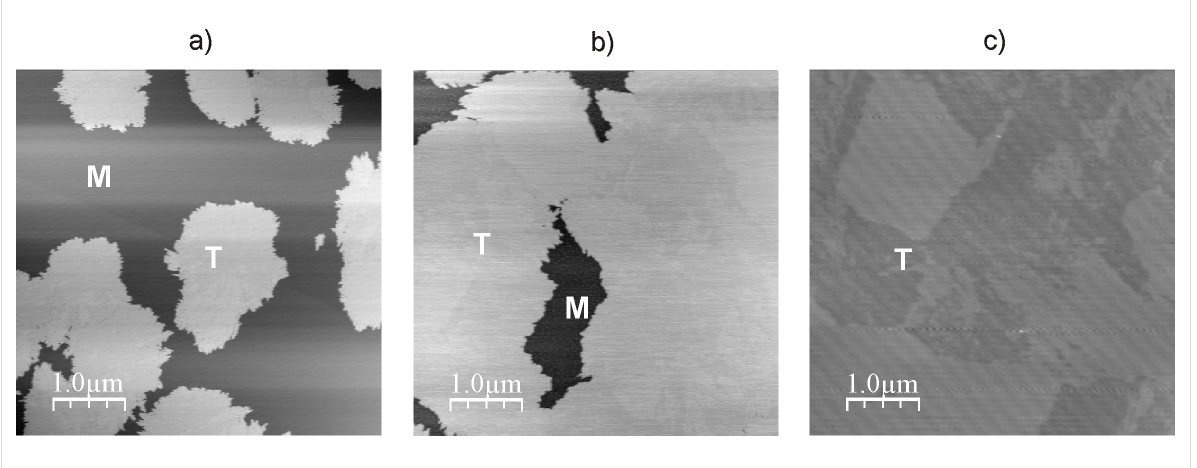
Figure 5: Growth of the tectomer formed by the peptide Н -Gly 4 -NH( СН 2 ) 10 -NHGly 4 - Н (concentration 0.1 mg/mL) on a mica surface at рН 6.5, with tapping mode, SFM on air, and a t е xp of а ) 0.5 min, b) 1 min, c) 2 min. Here, the shown field is completely covered with tectomer layer; its roughness found to be ± 0.1 nm. Т indicates the tectomer layer, M the uncovered mica regions.